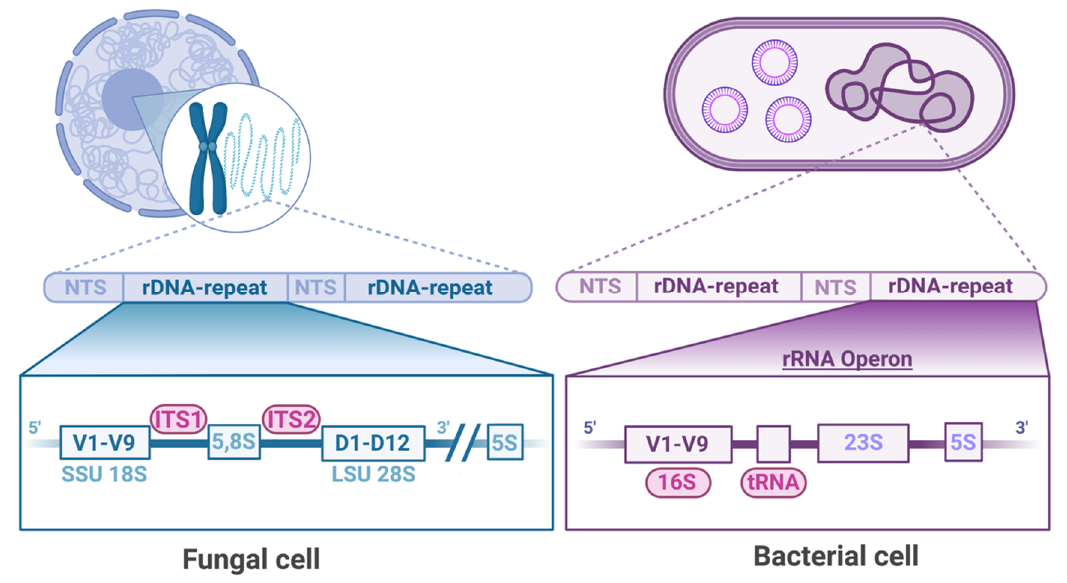
Figure 1. Comparison of targets for next-generation sequencing studies of fungal and bacterial microbiomes. The fungal microbiome is primarily identified by sequencing the internal transcribed spacer (ITS) fragments. The bacterial microbiome is analyzed by sequencing the prokaryotic 16S rRNA subunit or tRNA. rDNA—reverse DNA; ITS—internal transcribed spacer; LSU—large ribosomal subunit; tRNA—transfer RNA; NTS—non-transcribed spacer; SSU—small ribosomal